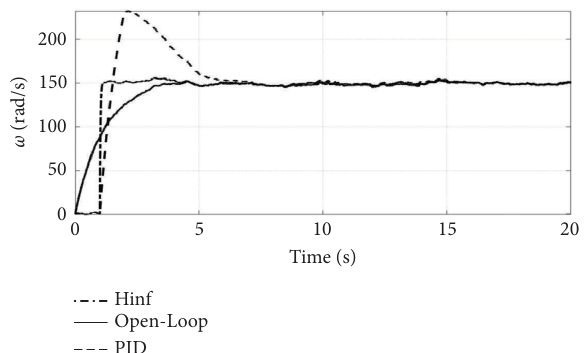
Figure 7: Te angular velocity of the frst order system for τ � 1s and stochastic